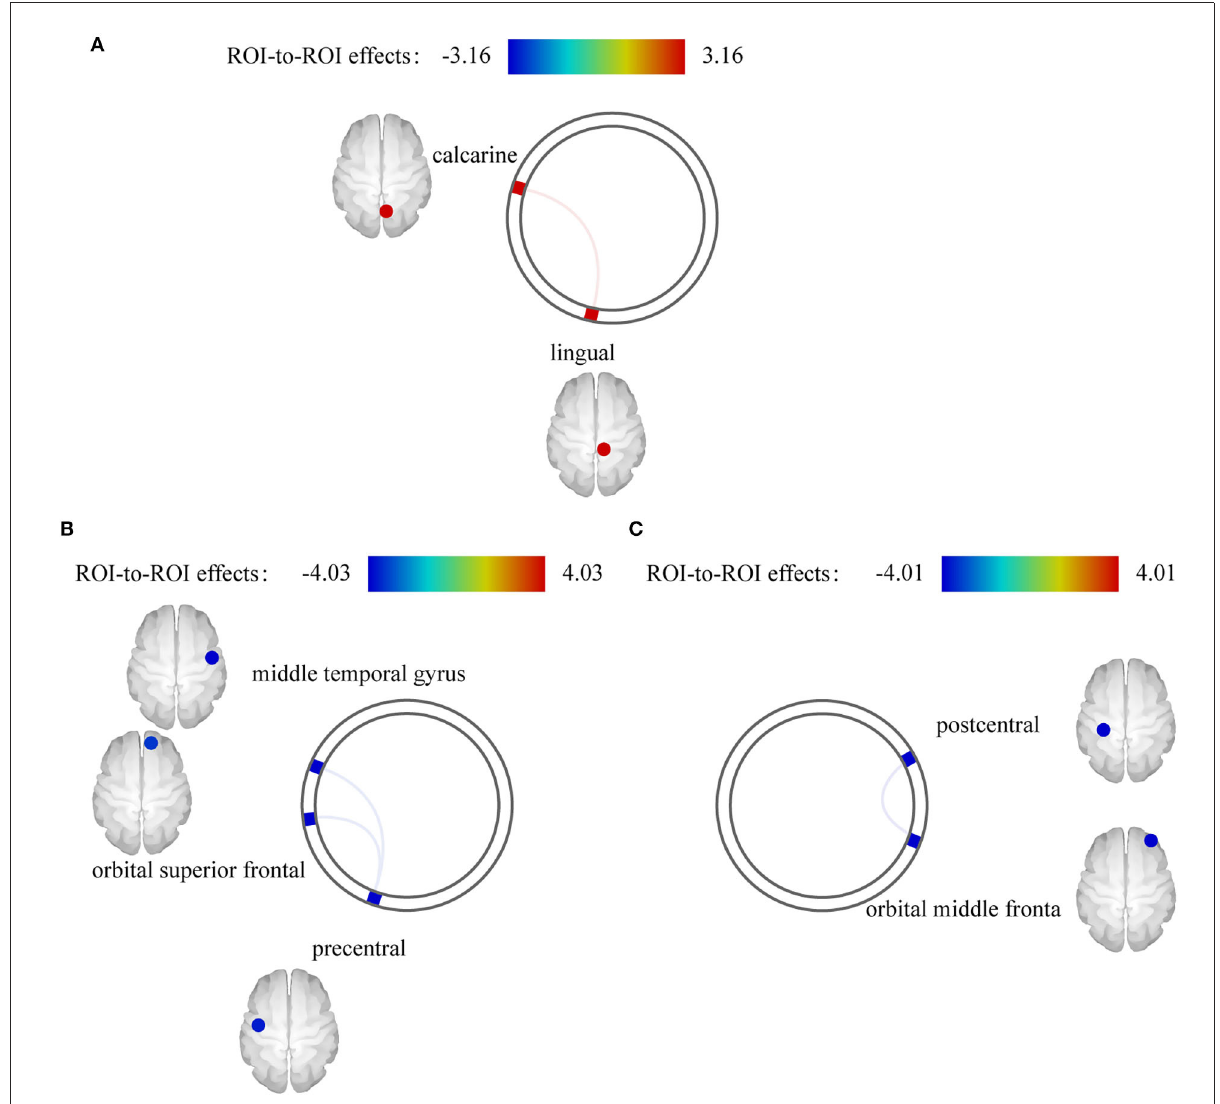
FIGURE4 Effect of electroacupuncture (EA) stimulation on static functional connectivity (FC). (A) Interaction effect on static FC. (B) EA stimulus-dependent changes in FC for the contrast of EA stimulation vs. rest at baseline in post stroke aphasia group. (C) EA stimulus-dependent changes in FC for the contrast of EA stimulation vs. rest at baseline in healthy control